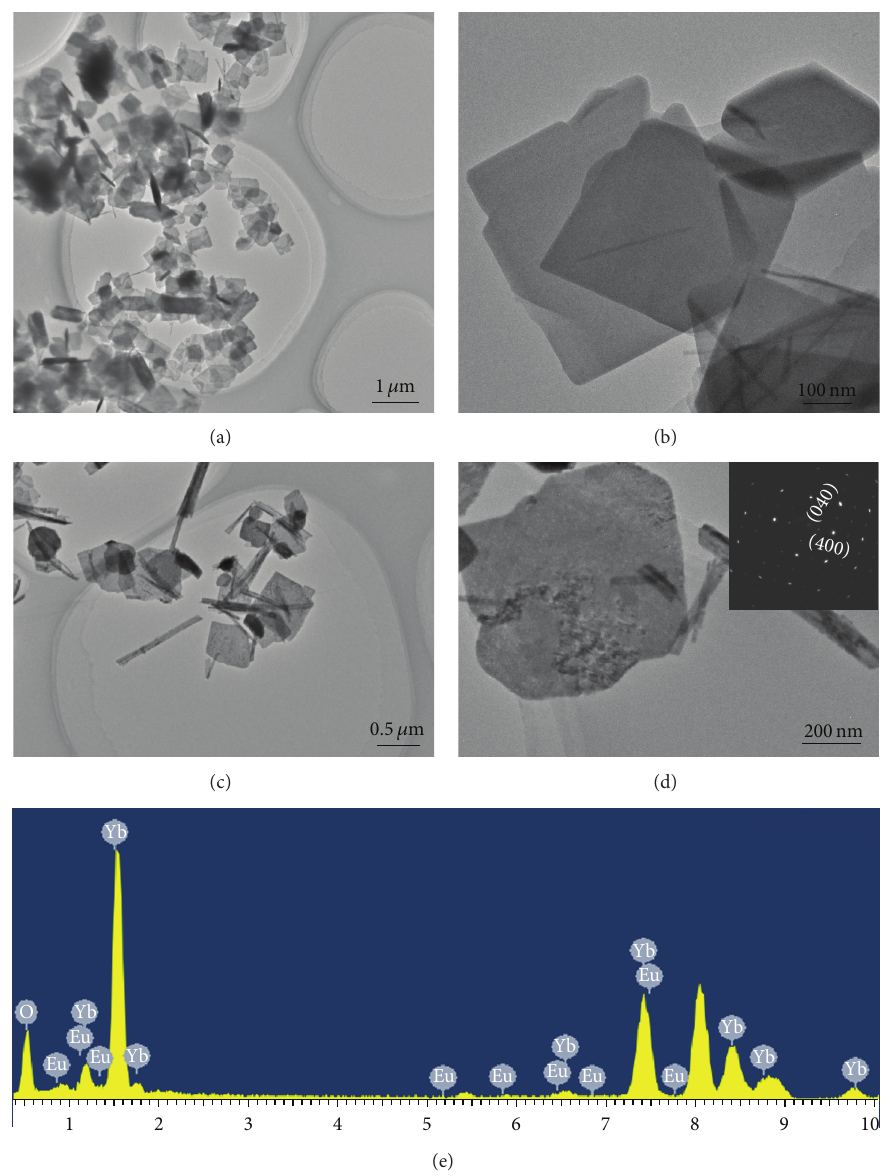
Figure 2: (a) TEM image of Yb(OH) 3 :Eu 3+ nanosheets; (b) highly magnified TEM image of individual Yb(OH) 3 :Eu 3+ nanosheets; (c) TEM image of Yb 2 O 3 :Eu 3+ nanosheets and nanotubes; (d) highly magnified TEM image of individual Yb 2 O 3 :Eu 3+ nanosheets and nanotubes;